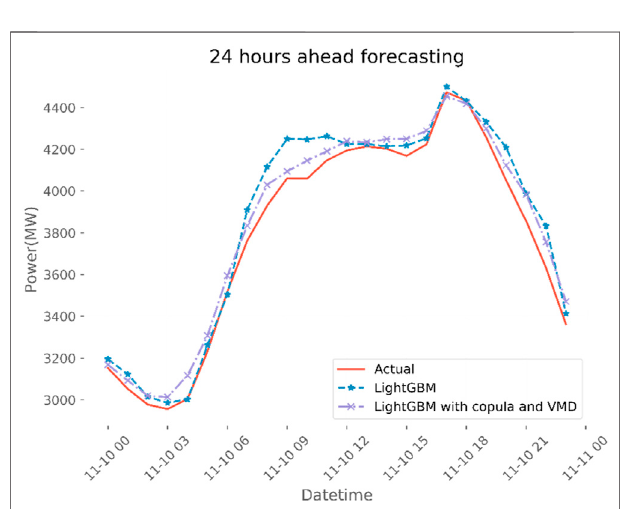
FIGURE 4 | Forecasting results with LightGBM algorithm, copula and VMD theory.